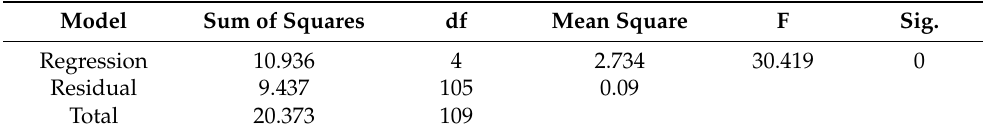
Table 1. ANOVA test.